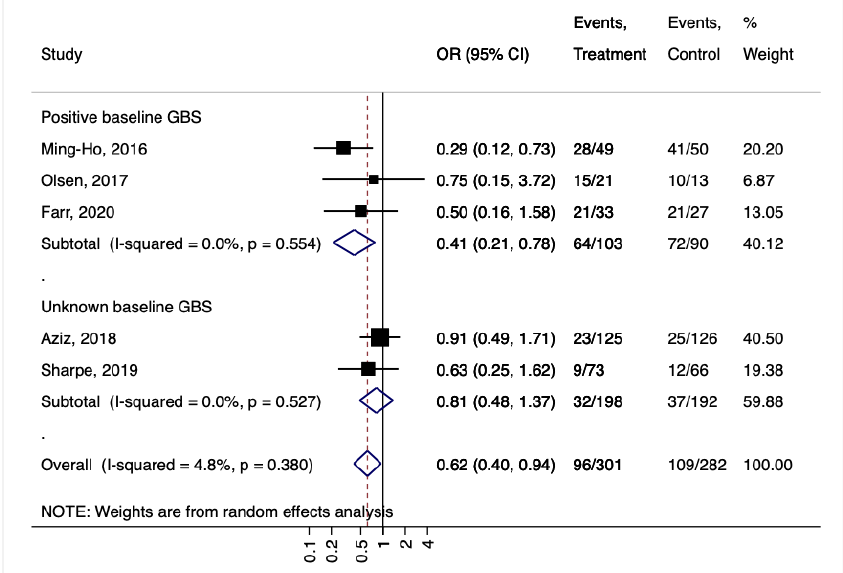
Figure 4. Forest plot for the GBS colonization according to positive or unknown GBS baseline.